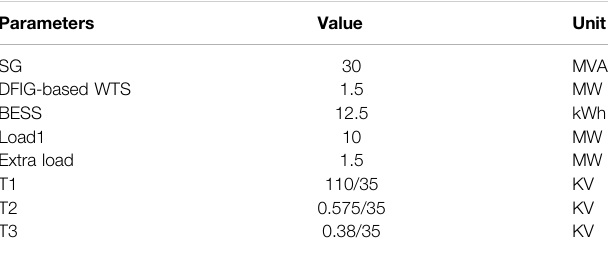
TABLE A1 | Parameters of the overall hybrid system.